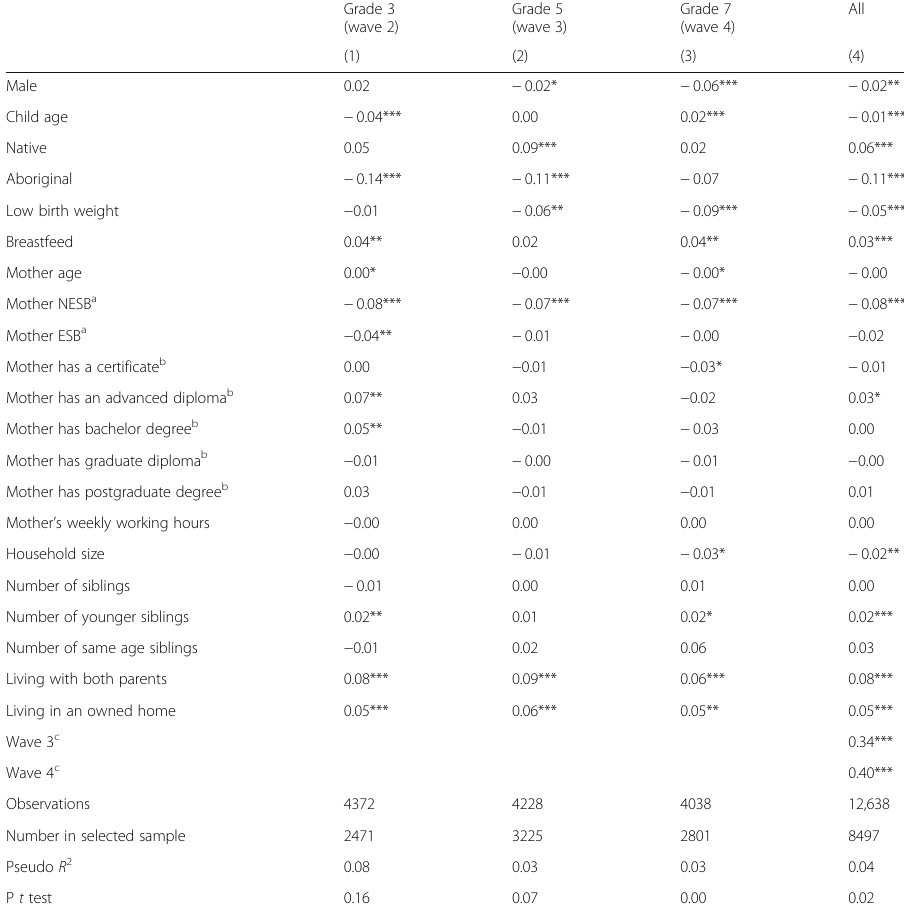
Table 7 Differences between original and selected